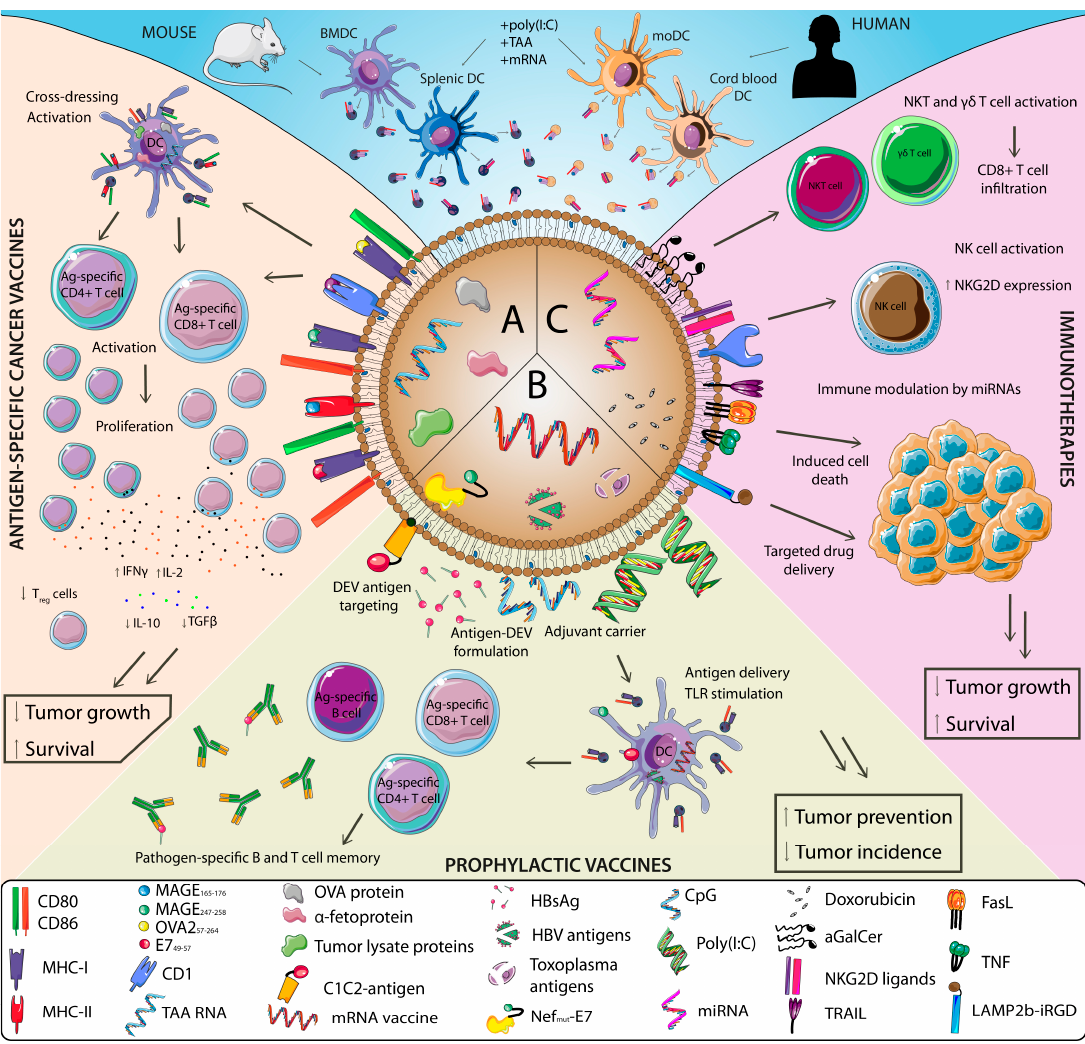
Figure 2. Therapeutic and prophylactic applications of DEVs in cancer. Mice and human DEVs have been used in antitumor studies as therapeutic or prophylactic agents. ( A ) DEV-based cancer vaccines have been designed by loading DEVs with peptide-loaded MHC (pMHC) molecules, tumor proteins and lysates, or mRNAs that encode neoantigens with the goal to mount antigen (Ag)-specific antitumor responses. ( B ) DEVs-based anti-pathogen vaccine platforms for cancer prevention have been designed either by natural-occurring antigen loading to DEVs or by fusing antigens to DEV proteins. Also, their ability as adjuvant carriers and antigen-DEV formulations has been explored to increase vaccine efficacy. In addition, DEVs are a potential platform for mRNA vaccine delivery. ( C ) DEVs have been used as immunotherapeutic agents by exploiting their immune stimulatory properties. DEVs can directly stimulate innate cells such as natural killer T cells (NKT), NK, and γδ T cells or modulate the immune response indirectly by the delivery of miRNAs; or induce tumor cell apoptosis via ligand interaction or targeted delivery of chemotherapeutics. MAGE, melanoma antigen gene; OVA, ovalbumin; E7, human papillomavirus E7 protein; HBV, hepatitis B virus; HBsAg, surface antigen of the HBV; Nef, negative regulatory factor from human immunodeficiency virus; α -GalCer, α -galactosylceramide; poly(I:C), polyinosinic:polycytidylic acid; FasL, Fas ligand; TNF, tumor necrosis factor; LAMP2b–iRGD, lysosome-associated membrane protein 2 (LAMP2b) fused to the integrin-specific peptide